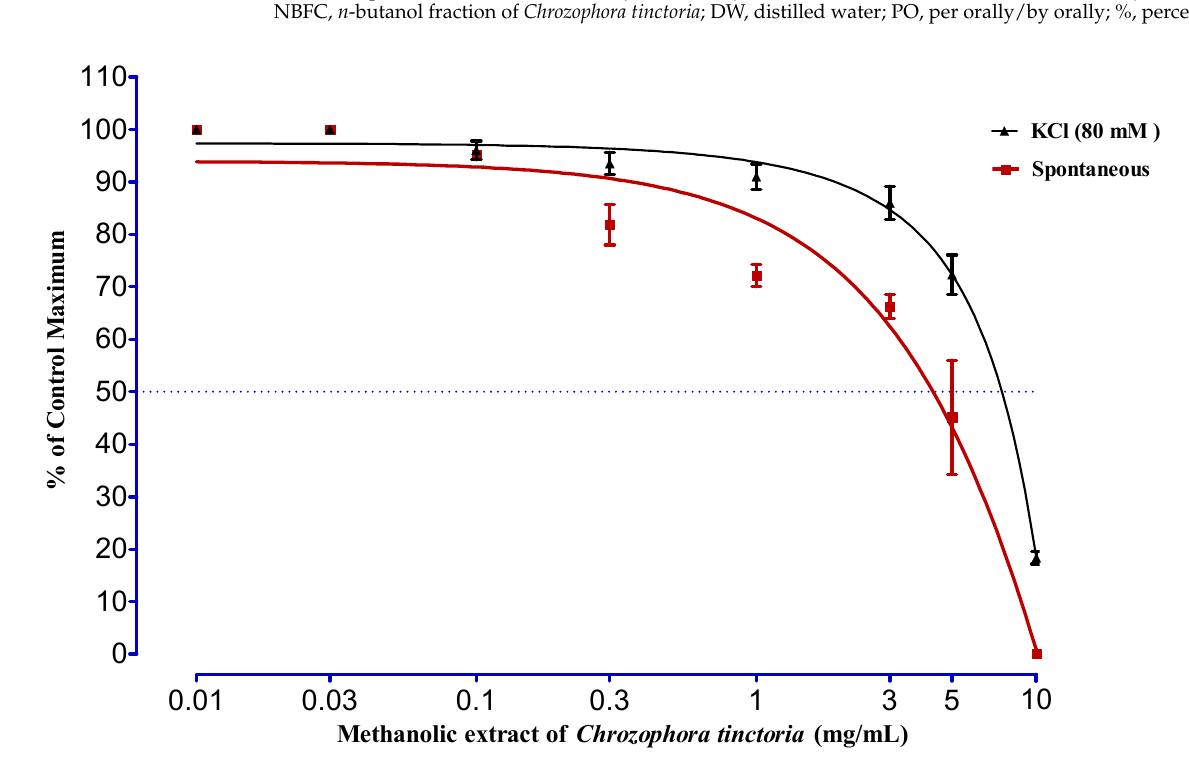
Figure 4. The effect of MEC on spontaneous and KCl-induced (80 mM) contraction of rabbit jejunum. Rabbit jejunum muscle was relaxed in a dose-dependent manner. EC 50 values were calculated from curve fitting in GraphPad Prism 6.01. Each point represents the mean ± SEM of grouped data. As shown in Figure 5, the n -butanol fraction of Chrozophora tinctoria was checked against spontaneous rabbit jejunum responses. The impression of the fraction started from 0.03 mg/mL to 10 mg/mL, and the maximum relaxing effect was at 10 mg/mL with an EC 50 value of 3.40 ± 0.20 mg/mL. The fraction with different concentrations was also evaluated against KCl-induced (80 mM) contraction. It was observed that the fraction was less potent at 0.03 mg/mL and was more influential at 10 mg/mL, with an EC 50 value of 7.22 ± 0.06